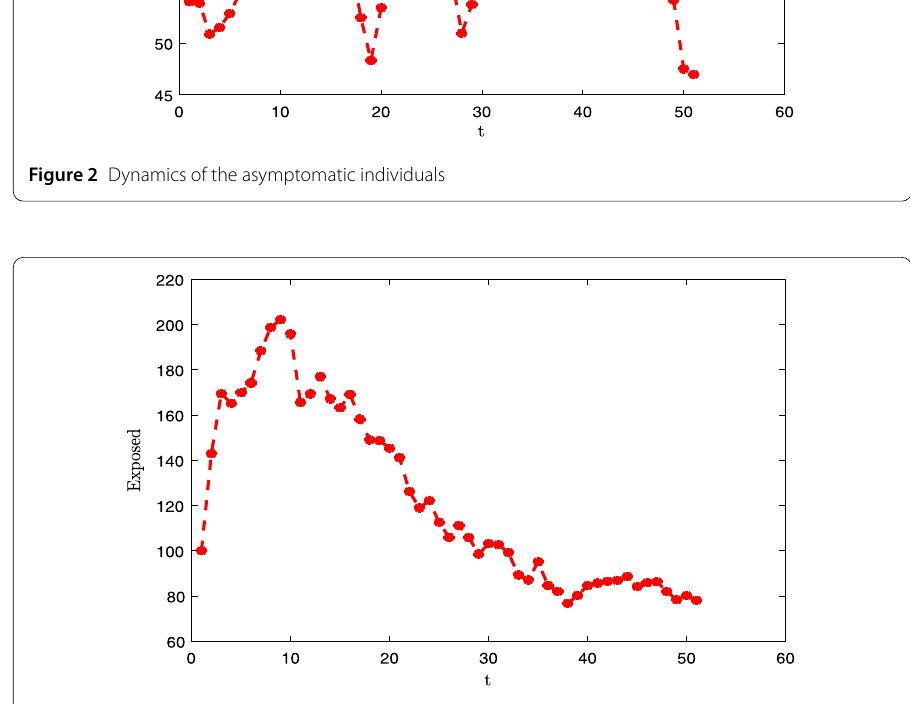
Figure 3 Dynamics of the exposed induviduals